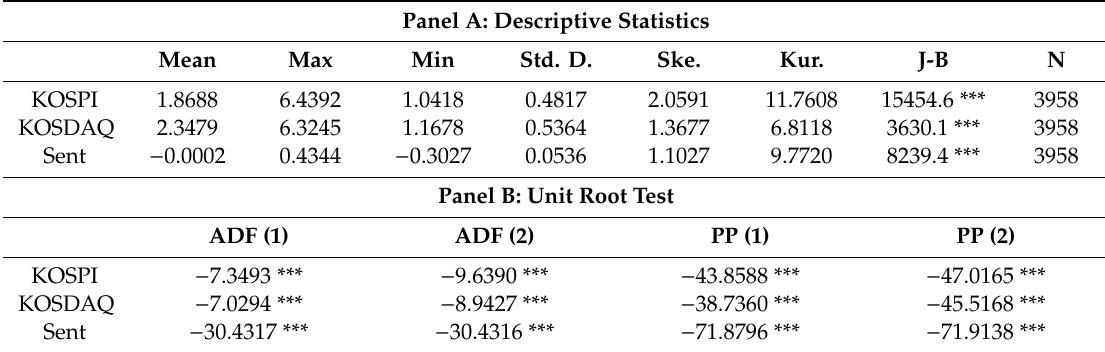
Table 1. Descriptive statistics and unit root test of CSAD and Sent. Panel A: Descriptive Statistics